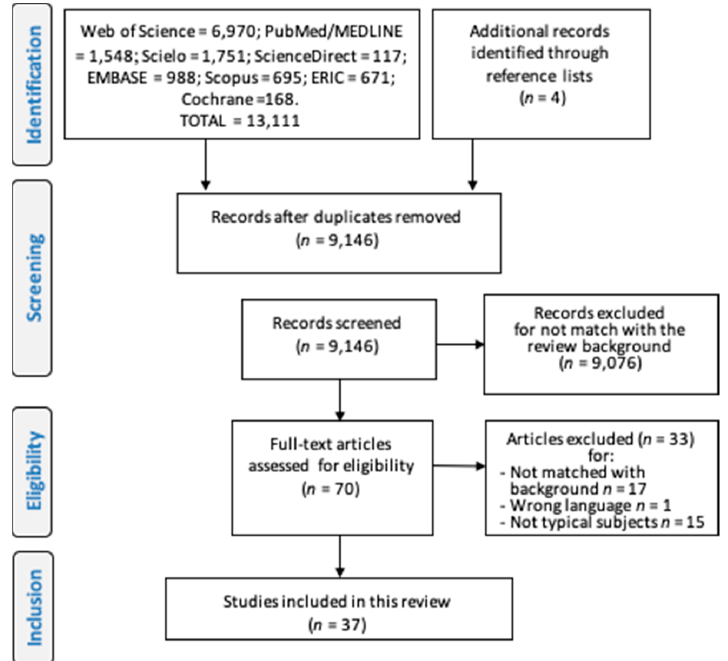
Figure 2. Flowchart describing the process to include studies in the systematic review according to the PRISMA-P protocol. The figure was originally created by the authors.